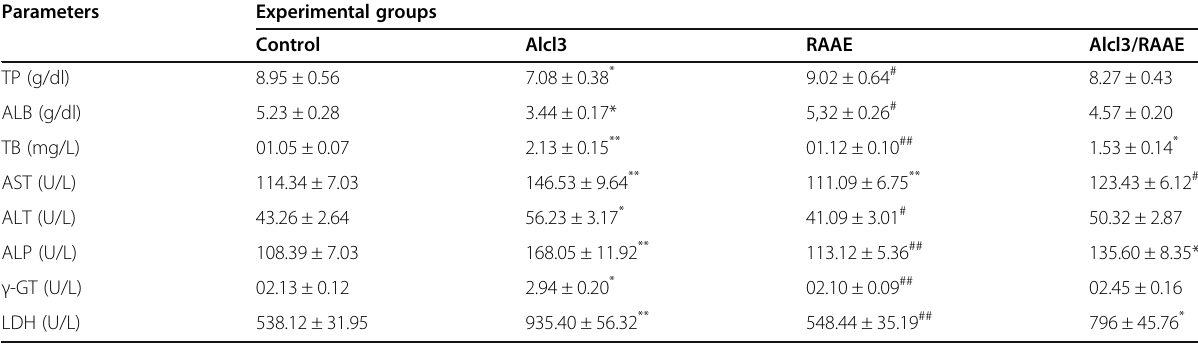
Table 3 Plasma hepatic function parameters